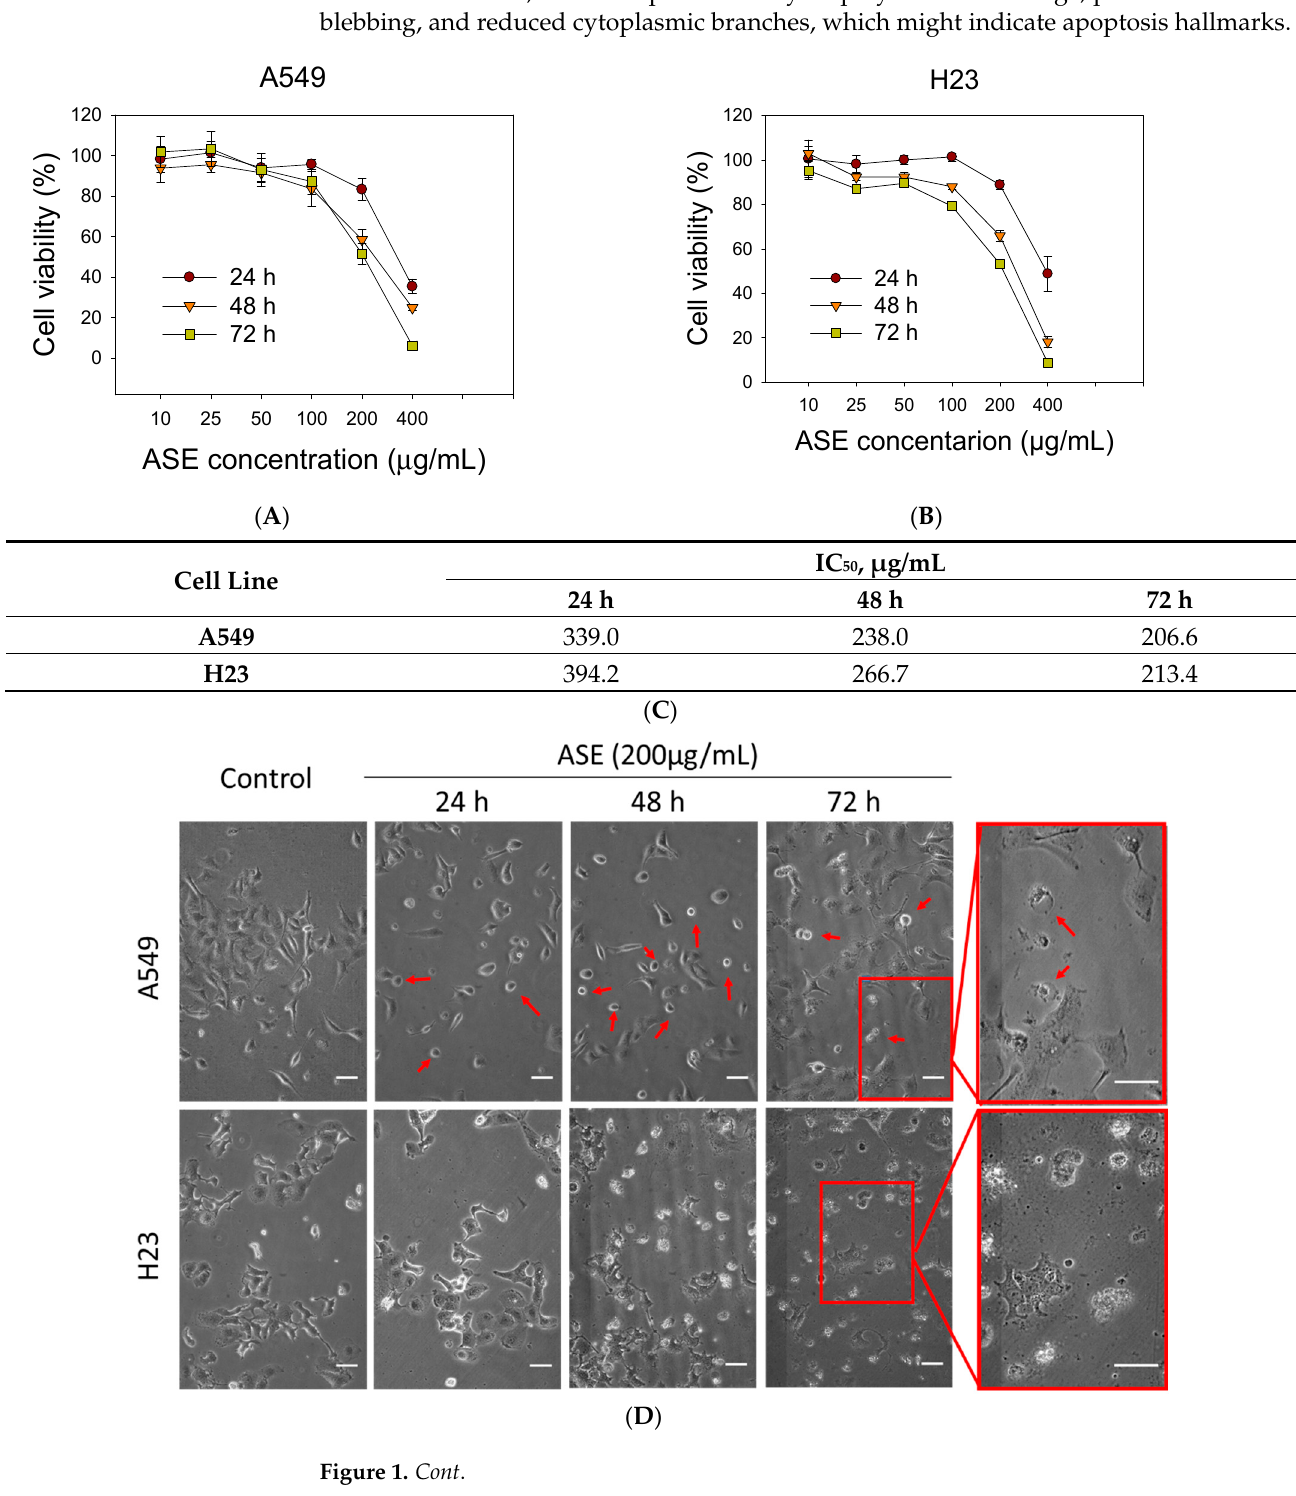
( E ) Figure 1. Effect of Artemisia santolinifolia ethanol extract (ASE) on cell growth of different non-small cell lung cancer (NSCLC) cell lines. Lung cancer cells were treated with different concentrations of the ASE for 24, 48, and 72 h. Cell viability of A549 ( A ) and H23 cells ( B ) was assessed by SRB assay. ( C ) The 50% inhibitory concentration (IC50) values were calculated at different time points. All data are the mean ± SE of three replicate experiments. ( D ) Light microscopic changes of cellular shape during ferroptosis. A549 and H23 cells were exposed for indicated durations to 200 μ g/mL ASE and observed by phase-contrast microscopy. Ferroptotic cells, presenting a typical rounded “balloon- ing” phenotype morphology, are indicated by red arrowheads. ( E ) Morphological changes after ASE treatment evaluated with Liu’s stain. Black arrows indicate a few examples of rounded, dying cells. Representative fields are shown. Scale bar = 50 μ m. 3.2. ASE Triggers Different Cell Death Features Active ingredients of Artemisia species were shown to induce various cell death modes (apoptosis, autophagy, ferroptosis, necrosis, necroptosis, and oncosis) through downregulating specific signal transducers [28]. Thus, ASE’s cytotoxicity toward NSCLC cells was evaluated by a flow cytometry analysis. The results of Annexin/7-AAD staining